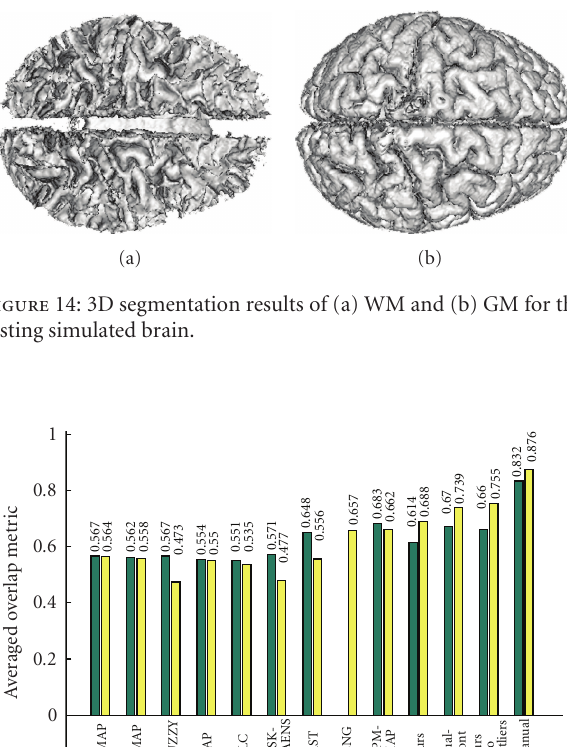
method [1], MPM-MAP: Bayesian method [14],and Dual-front: Dual-front method [5].